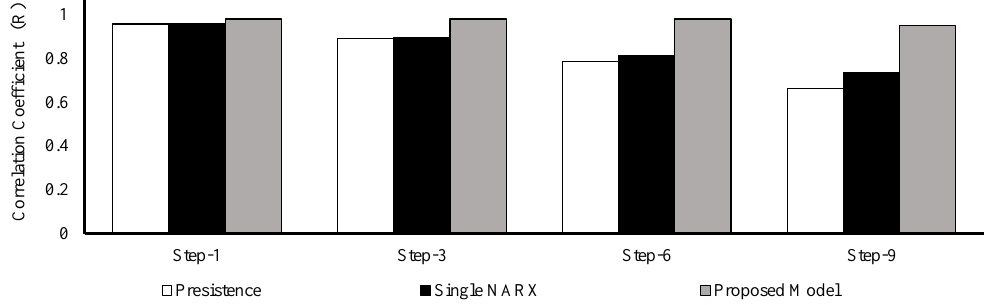
Figure 10. Correlation coefficient for the proposed ensemble NARX model vs. single-network NARX and persistence model at different time horizons.